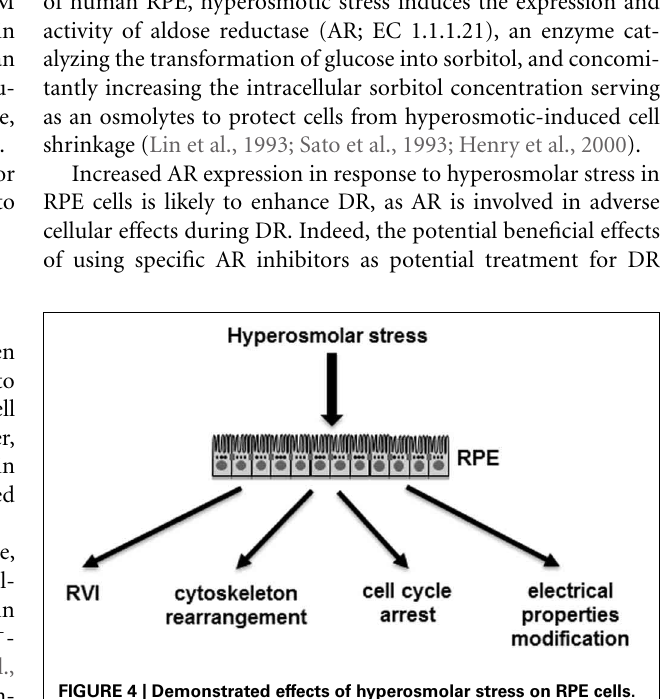
FIGURE 4 | Demonstrated effects of hyperosmolar stress on RPE cells. RPE, retinal pigmented epithelium monolayer; RVI, regulated volume